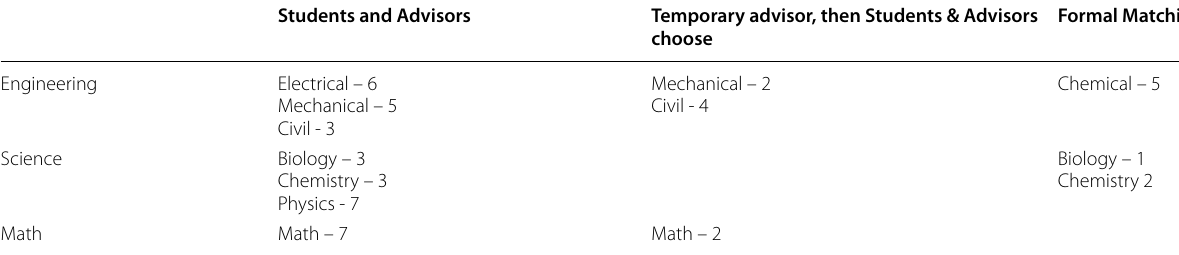
Table 2 Types of selection